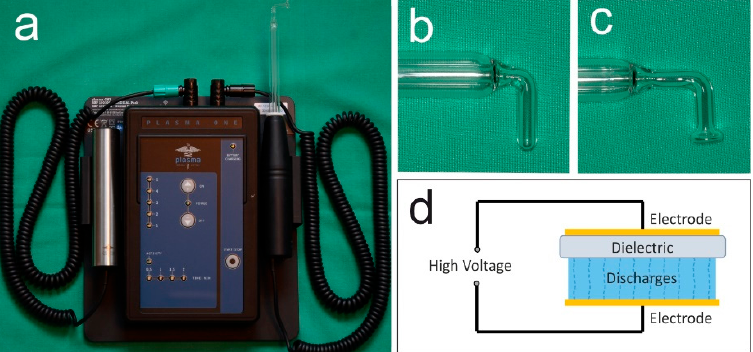
Figure 1. Ambient-air NIPP was generated by a dielectric barrier discharge ( a ) plasma ONE Dental (plasma Medical Systems GmbH, Nievern, Germany); ( b ) instrument probe PS08; ( c ) instrument probe PS12; ( d ) principle of dielectric barrier discharge.